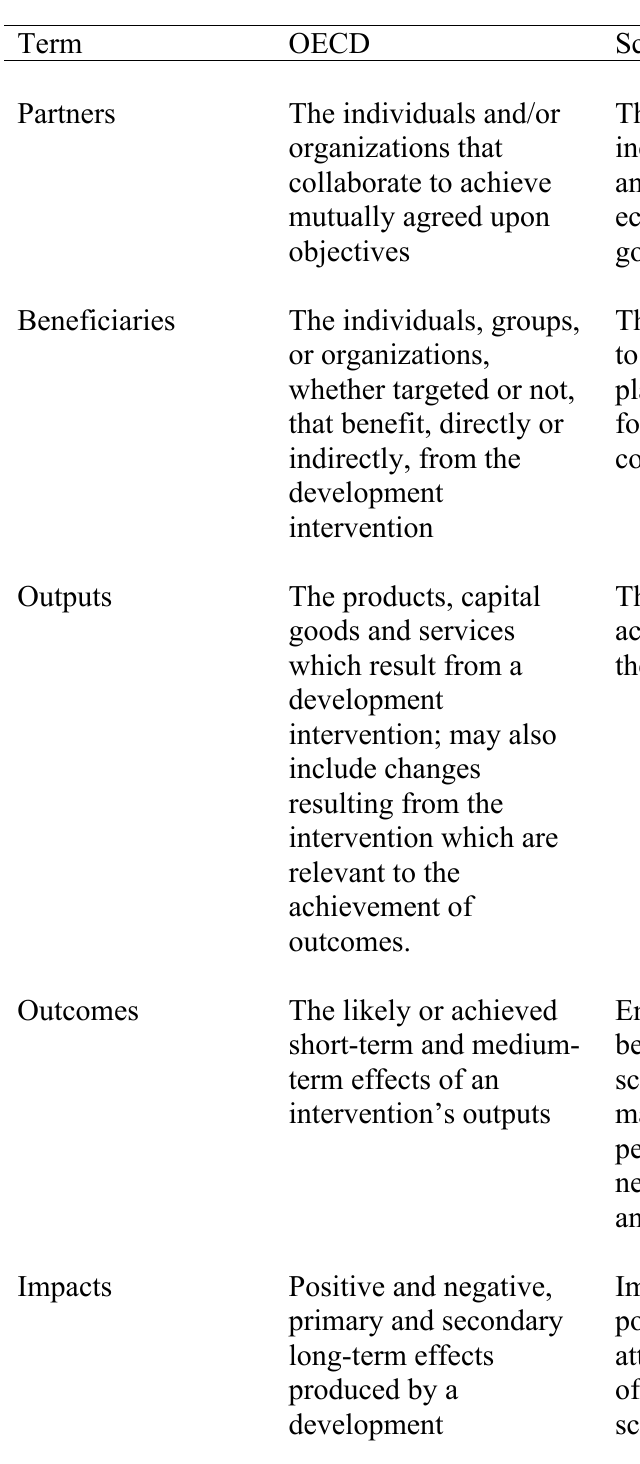
Table A8.1. Definitions (OECD 2002) and their adaption for scenario planning exercises (see